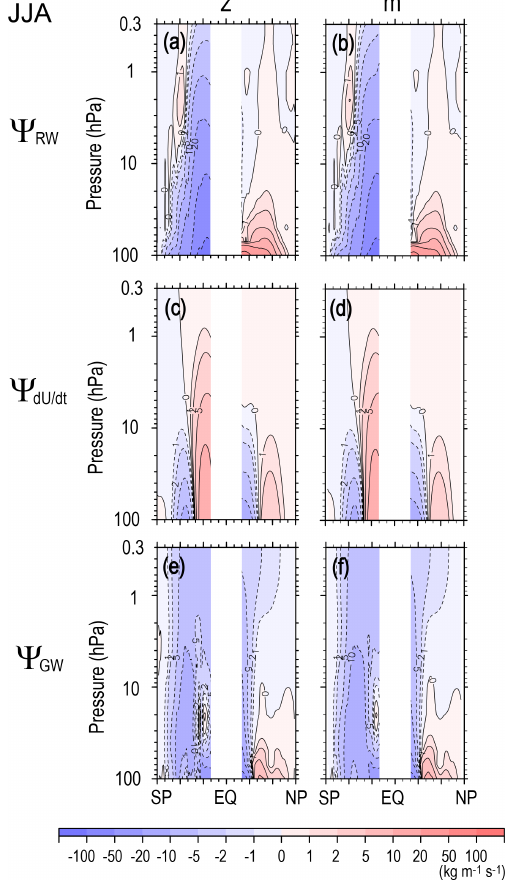
Figure B2. The same as Fig. B1 but for JJA. Next, the results be- tween the vertical and latitudinal integrations are compared. The annual mean (cid:57) (φ,z) obtained from the vertical (Fig. A1a) and lat- itudinal (Fig. 2a) integrations accord well with each other for the main part of the stratosphere, although the (cid:57) (φ,z) values from the vertical integration for the upper stratosphere and lower mesosphere above 5hPa are smaller in both the NH and SH than those from the latitudinal integration. This suggests that the residual mean circu- lation in the lower and middle stratosphere is mainly determined by the large wave forcing in the stratosphere, but the effect of the wave forcing in the mesosphere is not completely negligible for the circulation in the upper stratosphere above the levels with the large stratospheric forcing. These features are similarly observed for the equinoctial seasons (i.e., Figs. A1g and 8a for MAM).